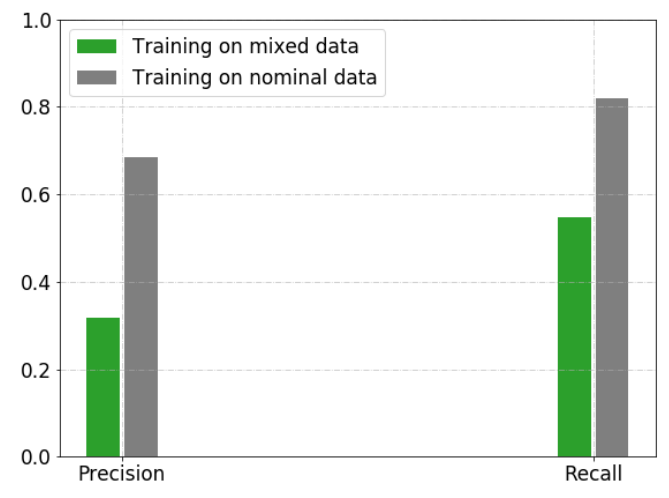
Figure 7. CVAE’s performance when trained only on nominal data or a mixture of nominal/anomalous